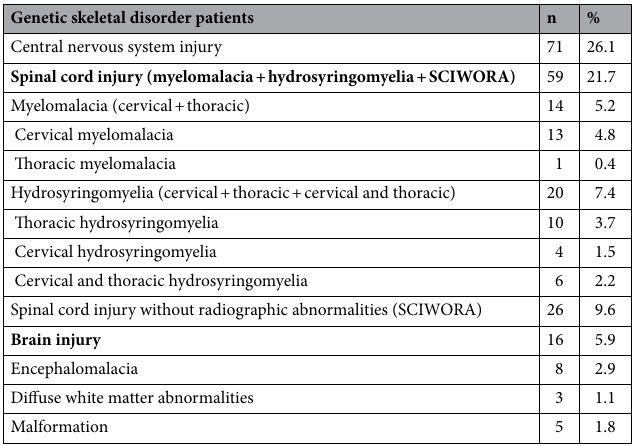
Table 2. The frequency of CNS injury in genetic skeletal disorder patients. Brain and spinal cord injury simultaneously occurred in four cases (1.5%), and myelomalacia and hydrosyringomyelia occurred in one case (0.4%). CNS central nervous system.